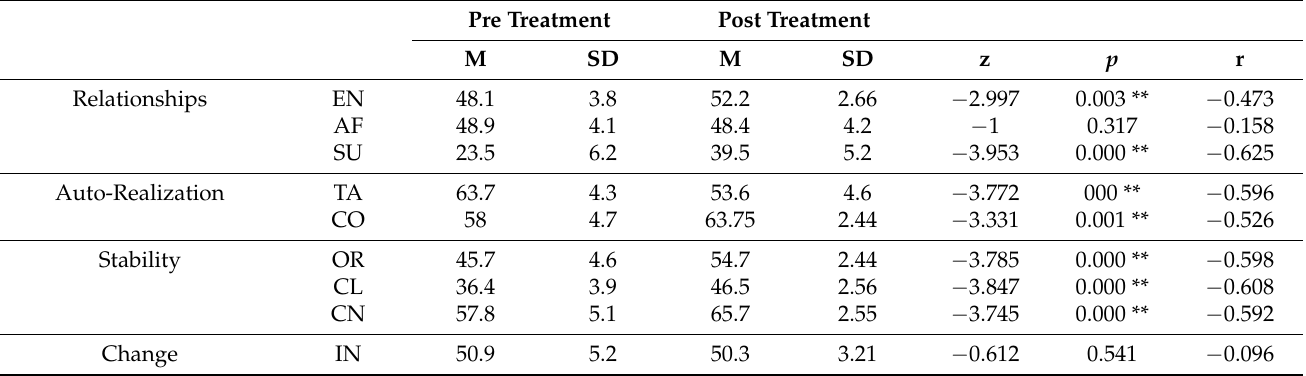
Table 6. Pre-post comparison of the multimodal group. School climate.